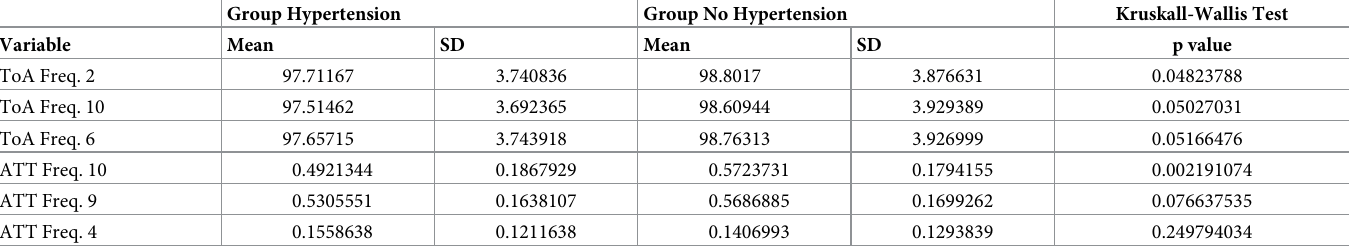
Table 3. Time of flight and attenuation measured for three different frequencies. The differences between the mean values of the two groups examined were checked using Kruskall-Wallis test. Group